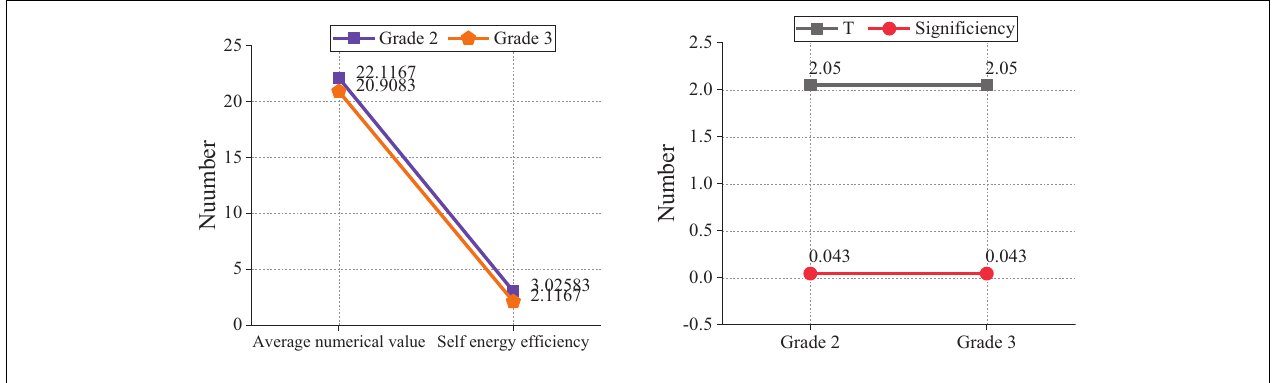
FIGURE 5 | T -test of grade score of college students’ self-efficacy.